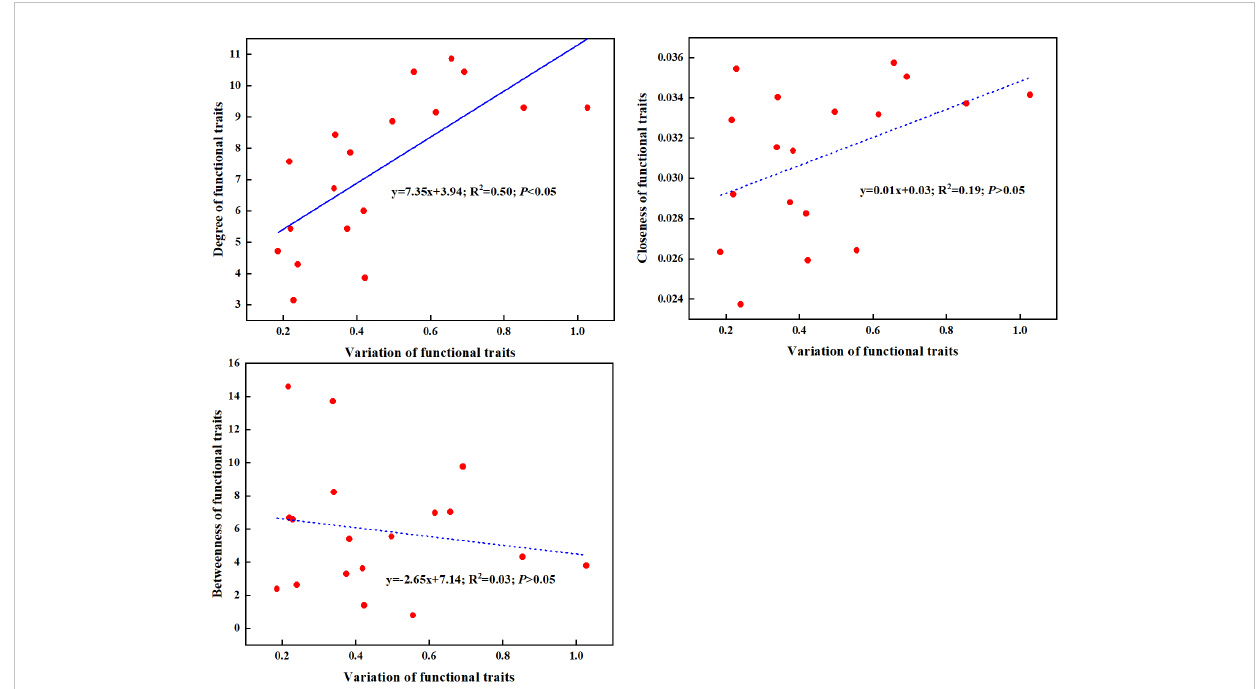
FIGURE 7 Linear regressions between functional traits variation and degree, closeness and betweenness. Dashed lines indicate that the slope of the linear regression is nonsigni fi